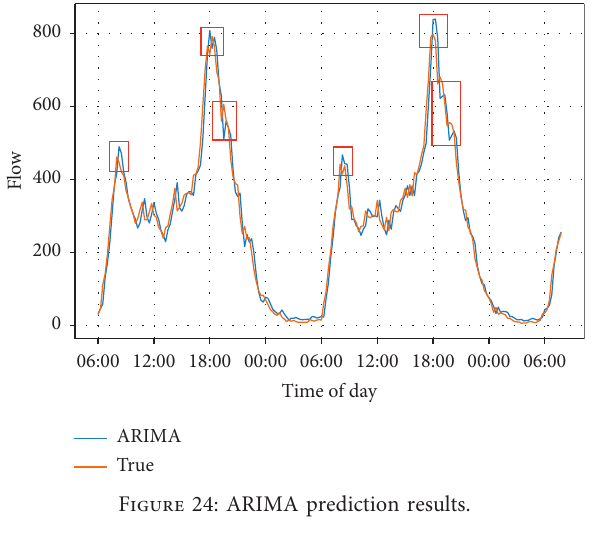
Figure 24: ARIMA prediction results.